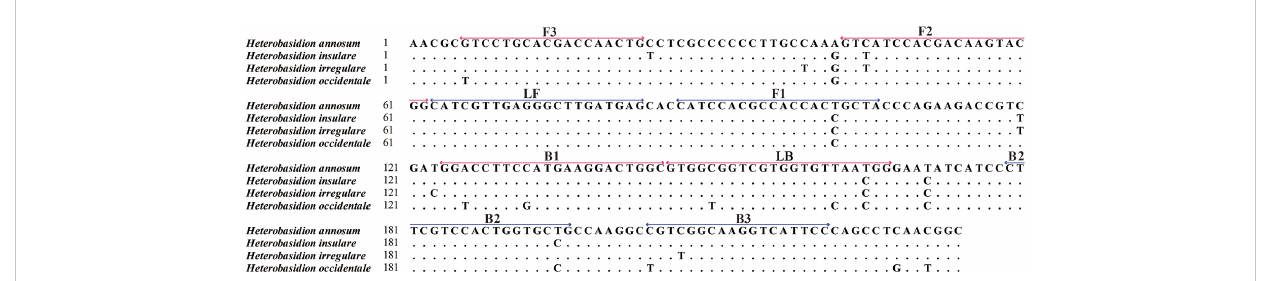
FIGURE 1 Genomic alignment between Heterobasidion annosum and H. insulare , H. irregulare , and H. occidentale at the locus selected for design of the LAMP primer sets. The locations of the designed primers (F3 – B3) are shown: forward primer FIP includes the F1 and F2 regions; backward primer BIP includes the B1 and B2 regions; and loop primers include the LB and LF regions. (Red color represents the forward primers, and blue color represents the reverse